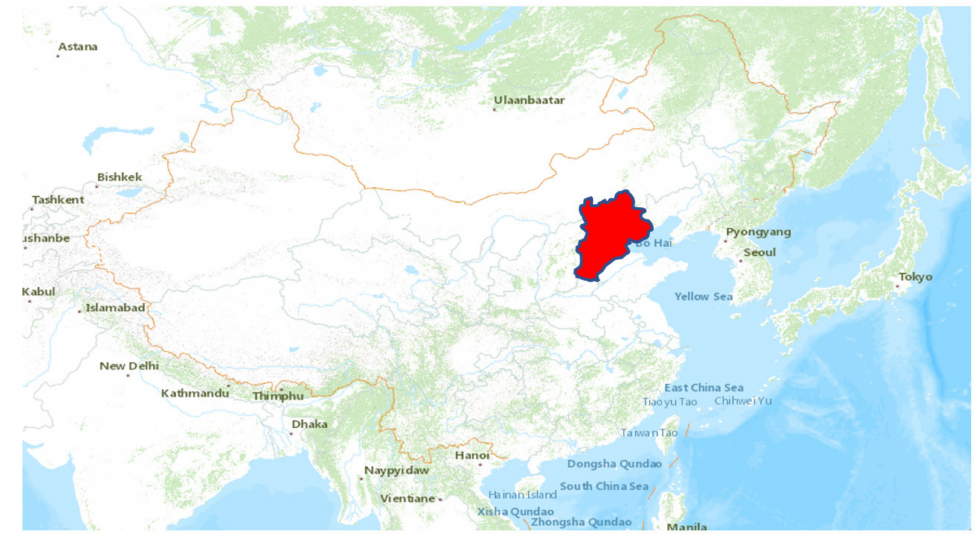
Figure 1. Study area: Beijing-Tianjin-Hebei urban